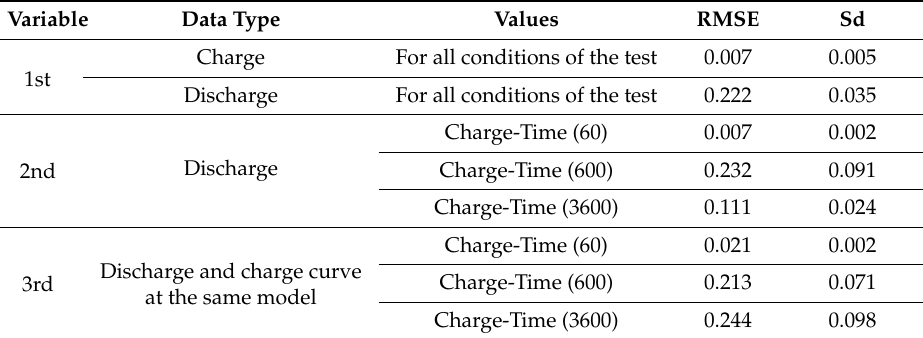
Table 4. Obtained statistical results in different approaches and at different